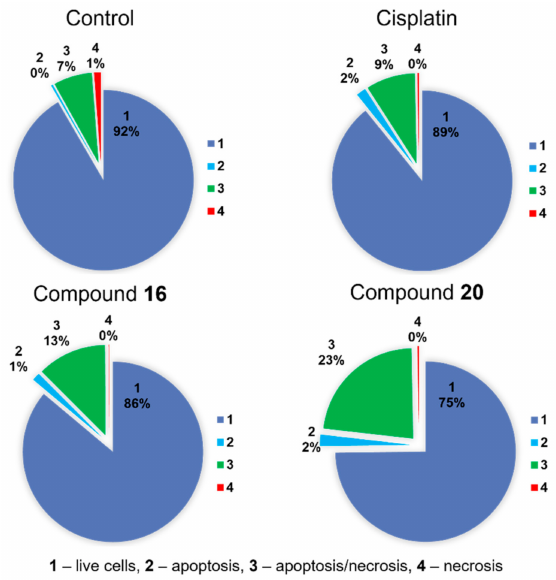
Figure 9. Cytometry studies of caspase 3/7 activation on the HCT116 cell